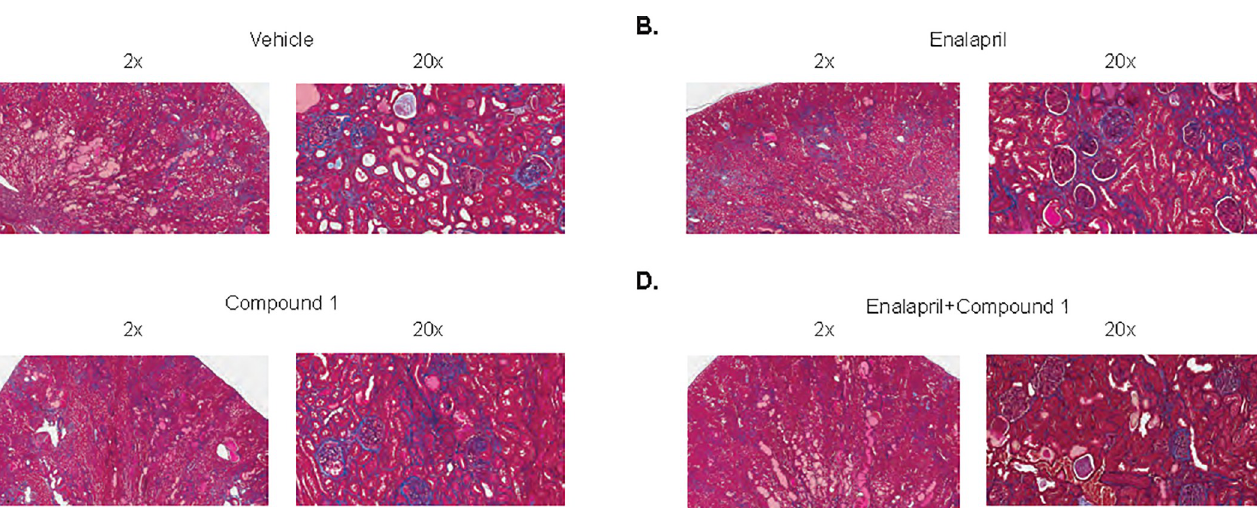
PLOS ONE | https://doi.org/10.1371/journal.pone.0261000 January 27,